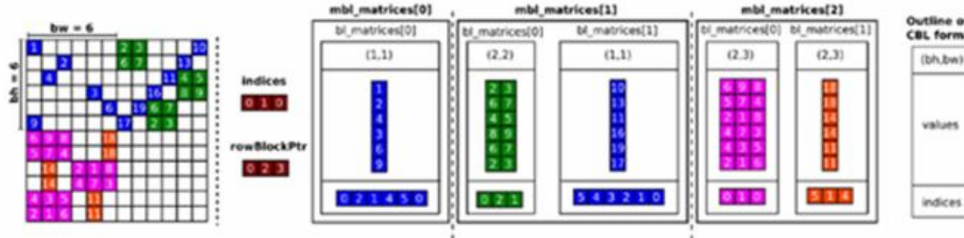
Figure 9. Regularized Multi Block (RMB) sparsity pattern for GPU memory [63]. (Reprinted with permission from ref. [63]. Copyright 2021 IEEE).